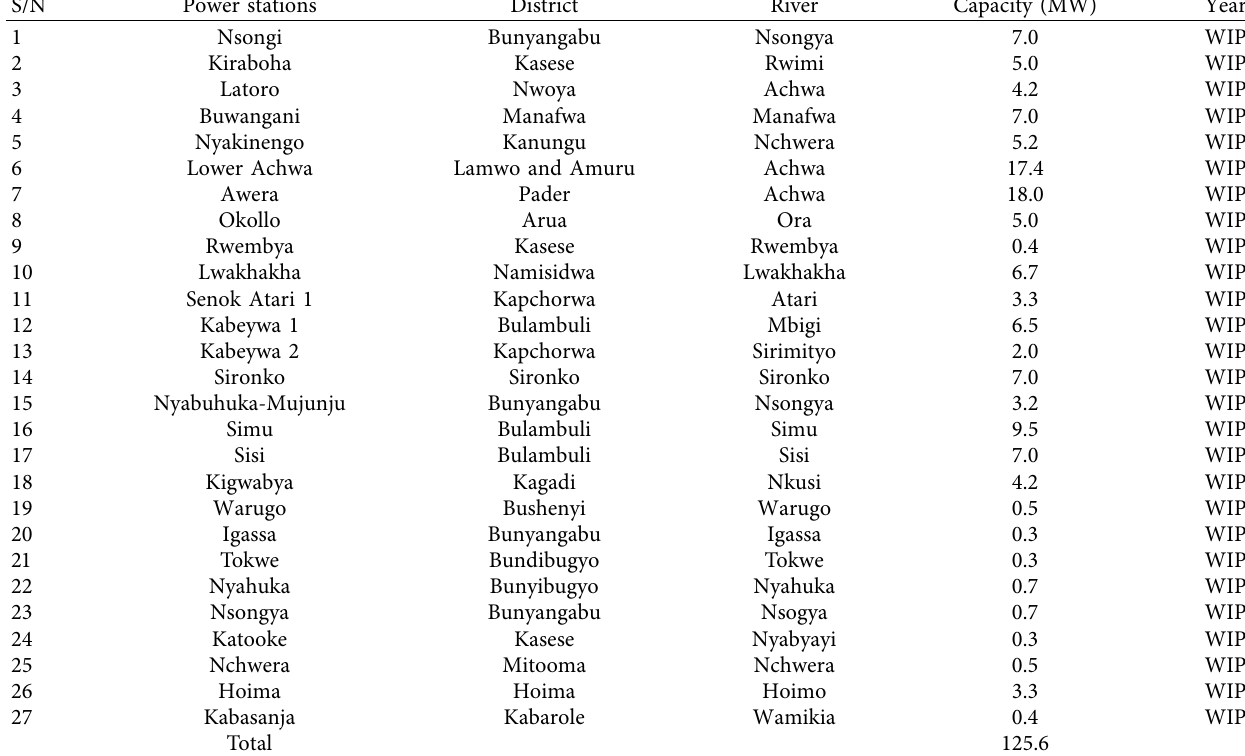
Table 7: Proposed small hydropower